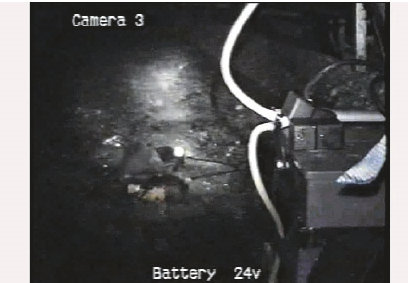
Figure 7: Mod robot and photos taken in environment of mine disaster.